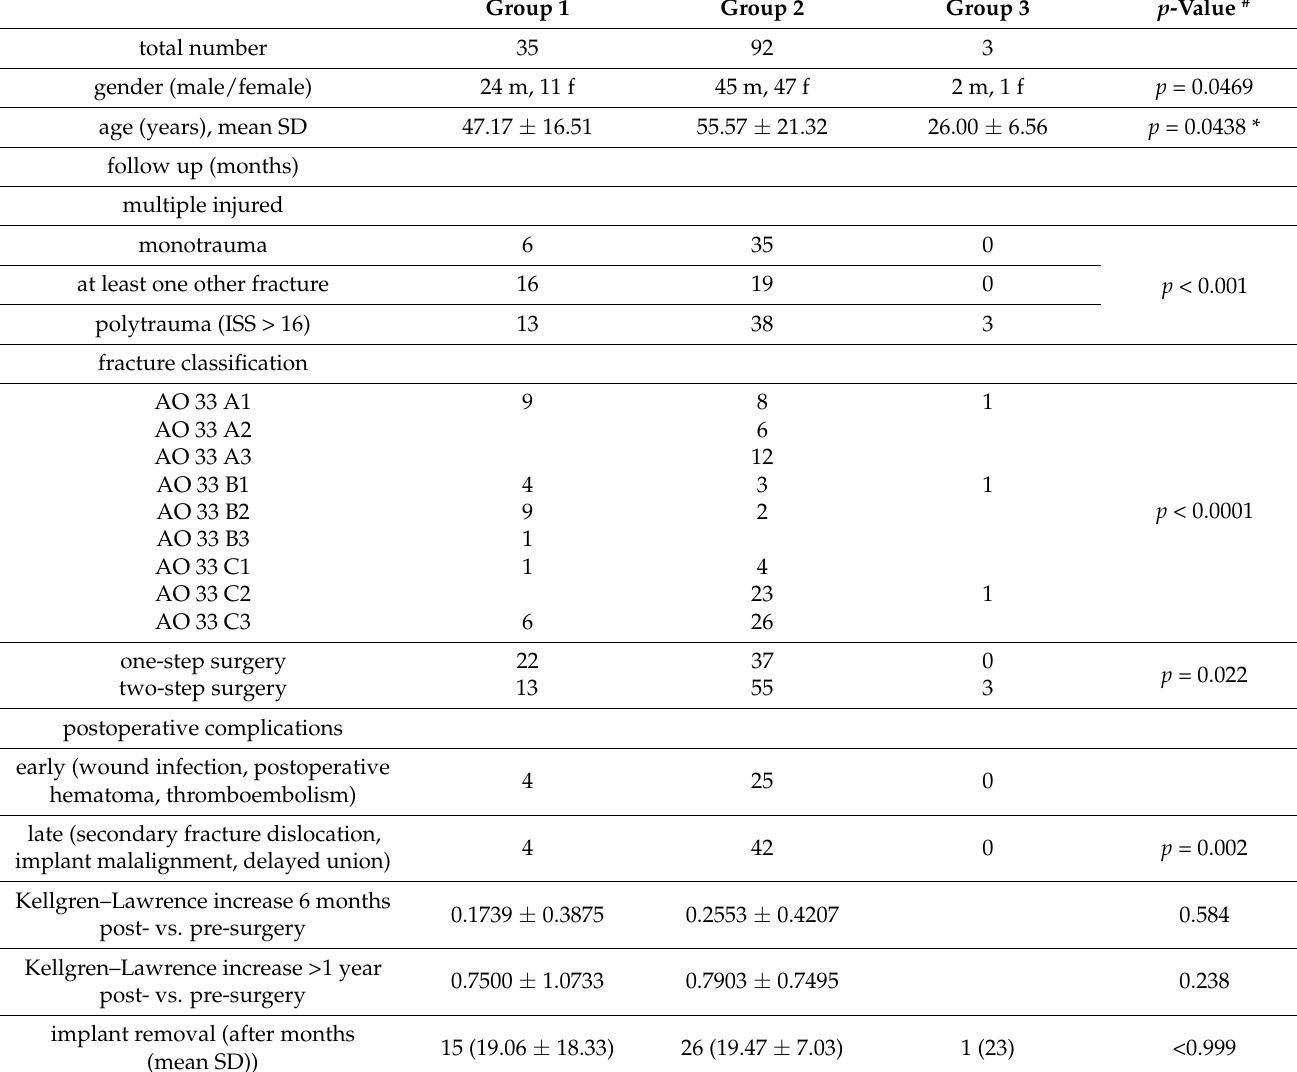
Table 2. Overview of patient and injury-related factors of the retrospective cohort